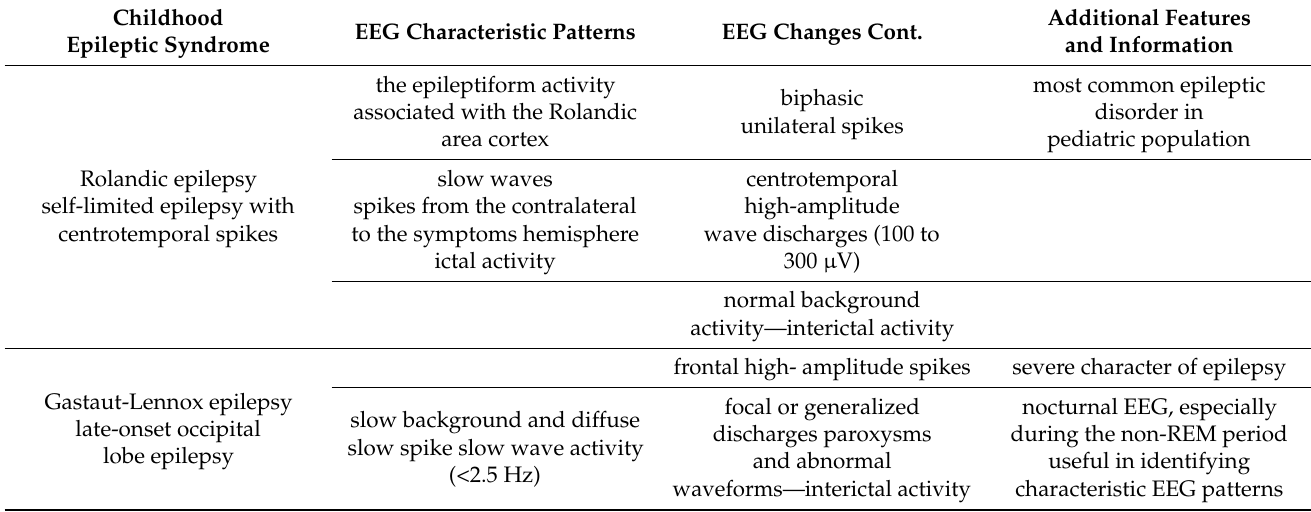
Table 2. This table compares EEG patterns characteristic ofselected childhood epileptic